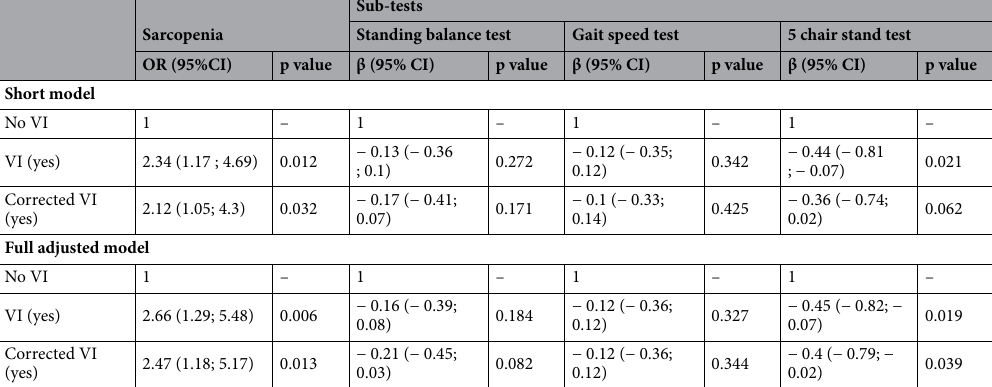
Table 2. Association between self-reported visual impairment and sarcopenia and the SPPB subtests. Short model was adjusted for age and sex. aOR adjusted odds ratio. H Adjusted for: age, sex, marital status, school level, cognitive impairment, IADL score, nutritional status, hypertension and